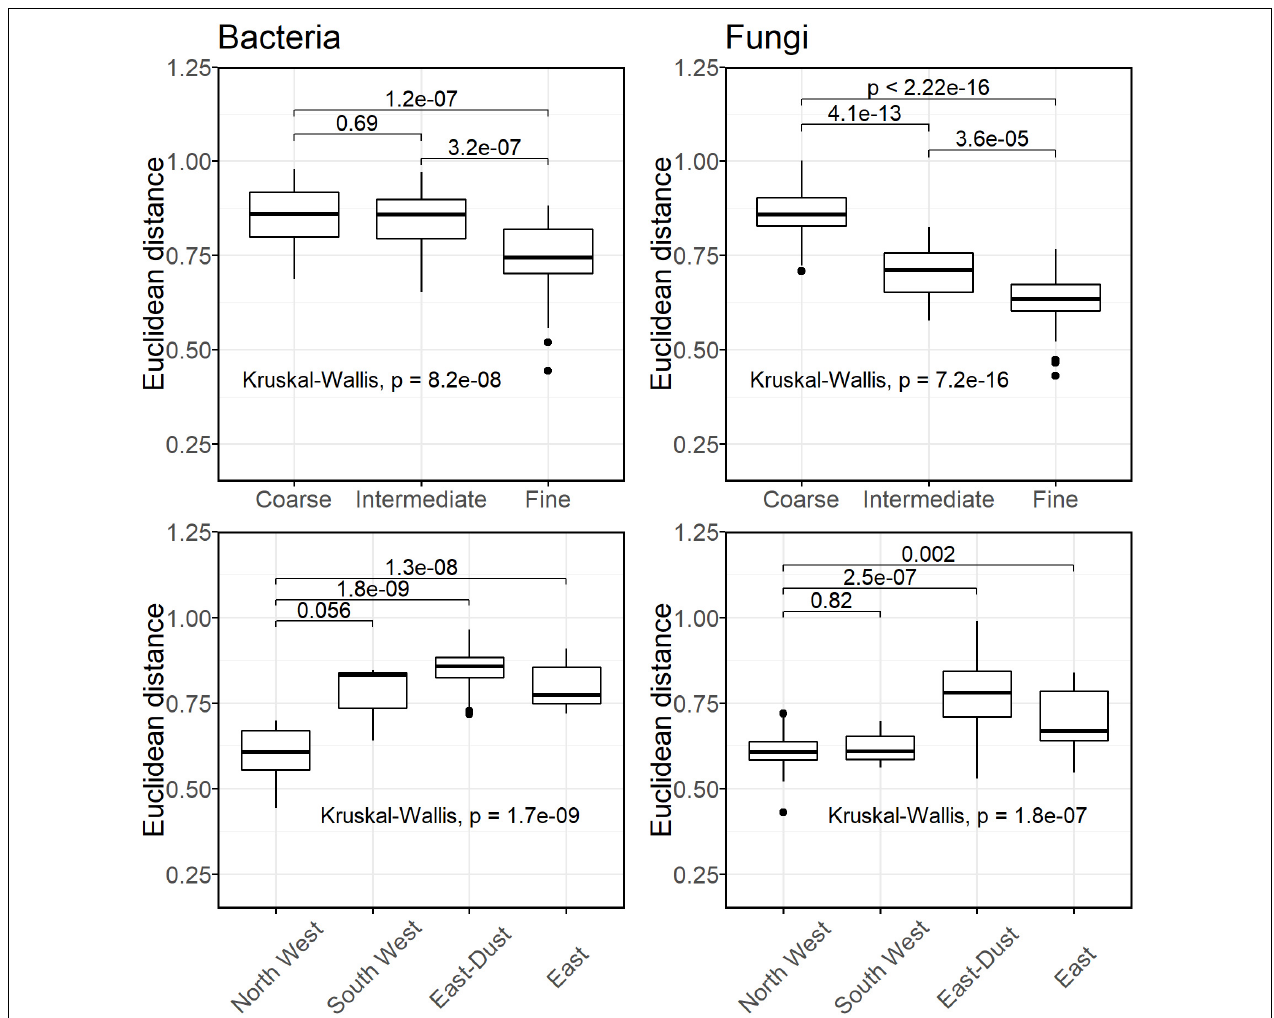
FIGURE 2 | Distribution of Euclidean distances within groups of bacterial (Left column) and fungal (Right column) communities. Lower Euclidean distances suggest a lower within-group